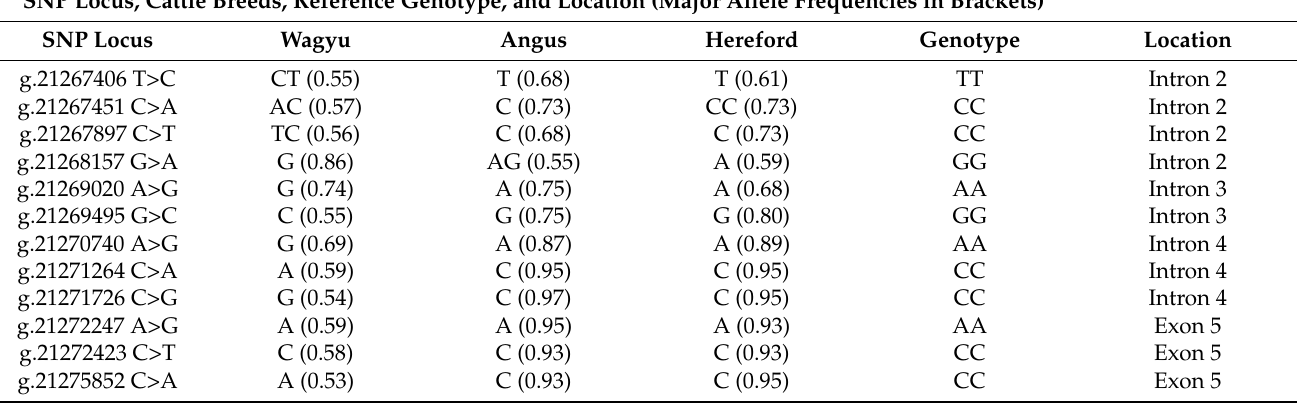
Table 2. SCD gene SNP in Bowen Genetics Forest Pastoral Angus, Hereford, and Wagyu beef cattle. SNP Locus, Cattle Breeds, Reference Genotype, and Location (Major Allele Frequencies in Brackets)